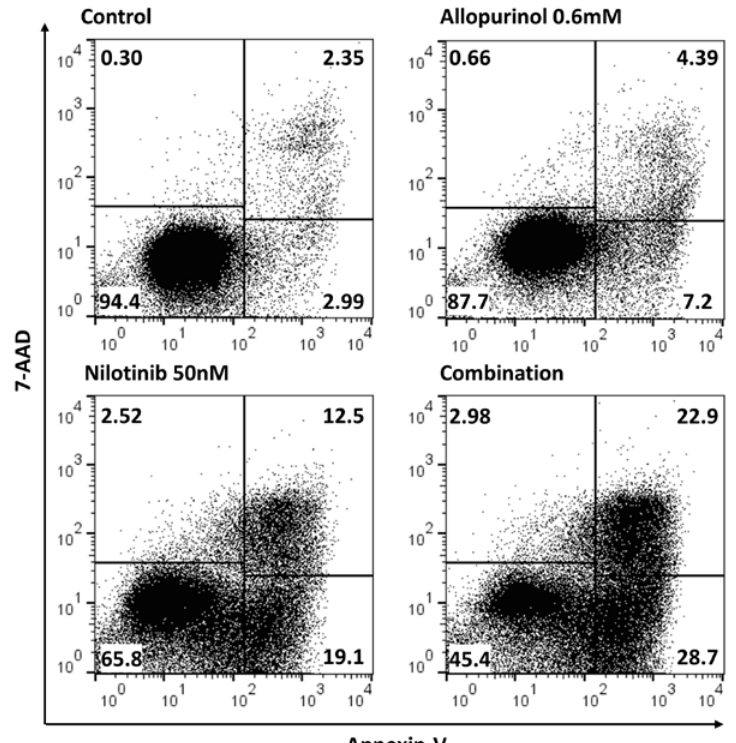
Figure 5. The combination of nilotinib and allopurinol induces K562 cell death more efficiently than individual treatments. K562 cells were treated with 50 nM nilotinib, 0.6 mM allopurinol or their combination for 48 h. Cell viability was analyzed by flow cytometry staining with Annexin-V / 7AAD: viable (Annex − / 7AAD − ), early (Annex + / 7AAD − ) and late (Annex + / 7AAD + ) apoptotic, and necrotic cells (Annex − / 7AAD + ). A representative flow cytometry diagram is shown ( n = 5). Table 1. Allopurinol and imatinib combination induces cell death in K562 and KCL22 cell lines. Cell Lines KCL22